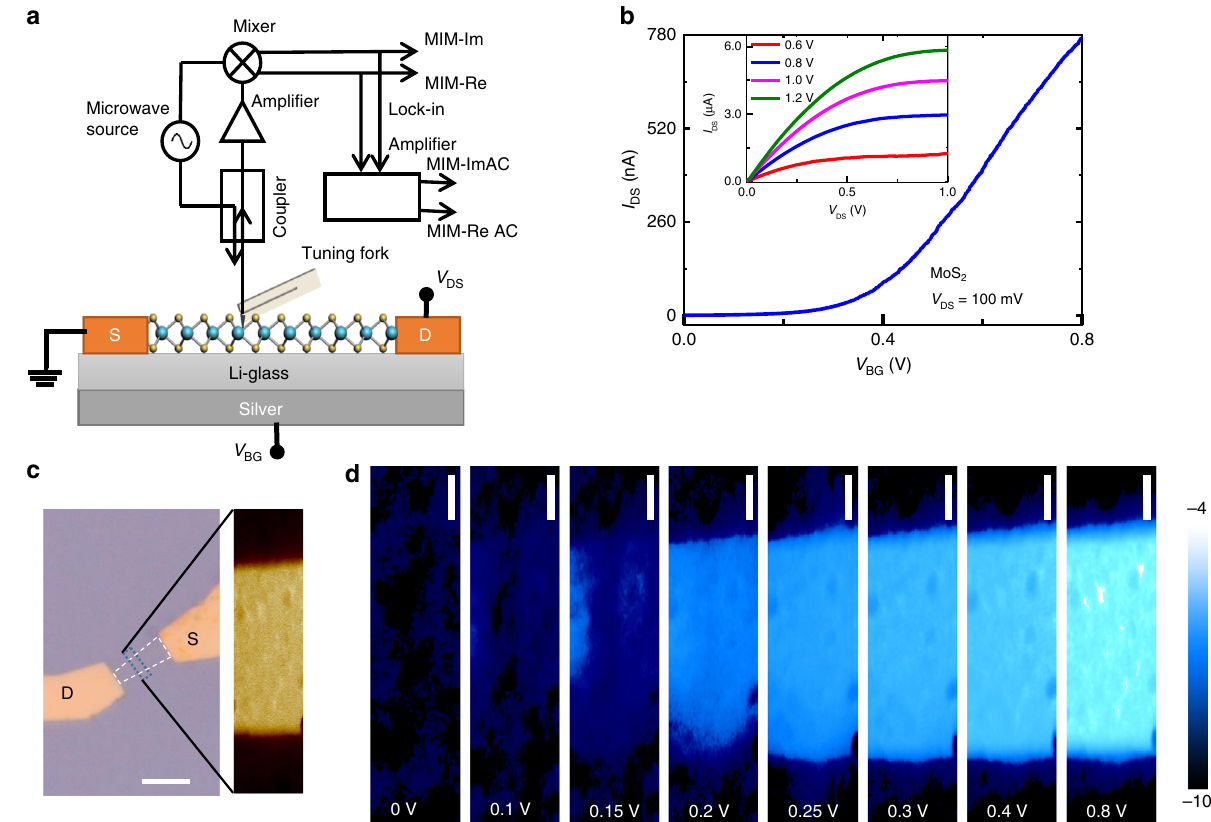
Fig. 5 MIM measurement of MoS 2 FET. a Schematic diagram of the device and the tuning-fork-based MIM setup. The 1-GHz microwave signal is guided to the tip through an impedance match section, and the re fl ected signal is detected by the MIM electronics. The carrier density is tuned by the back-gate voltage V BG . b Transfer characteristics of the MoS 2 FET ( L = 6 µ m) for V DS = 100 mV. Inset: Output characteristics for gate voltages from 0.60 V to 1.20 V in steps of 200 mV. c Optical image of the device, where white dashed lines show the channel boundary and the blue dotted line shows the section of the channel where MIM is performed. Inset shows MIM map of the selected channel region. Scale bar is 5 µ m. d Sheet conductance map in a section of the FET channel at different gate voltages. The color scale represents the common logarithm of sheet conductance in S/ ◻ . All scale bars are 500